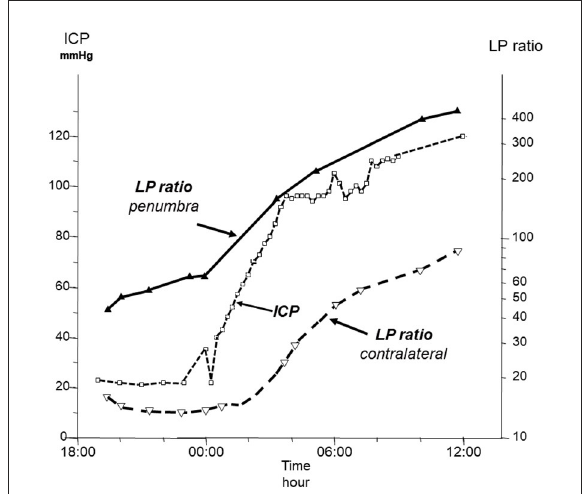
FIGURE1 Time course of intracranial pressure (ICP) and lactate/pyruvate (LP) ratio in the penumbra zone of a focal brain lesion and in the contralateral hemisphere in a patient with a fatal traumatic injury. Data from